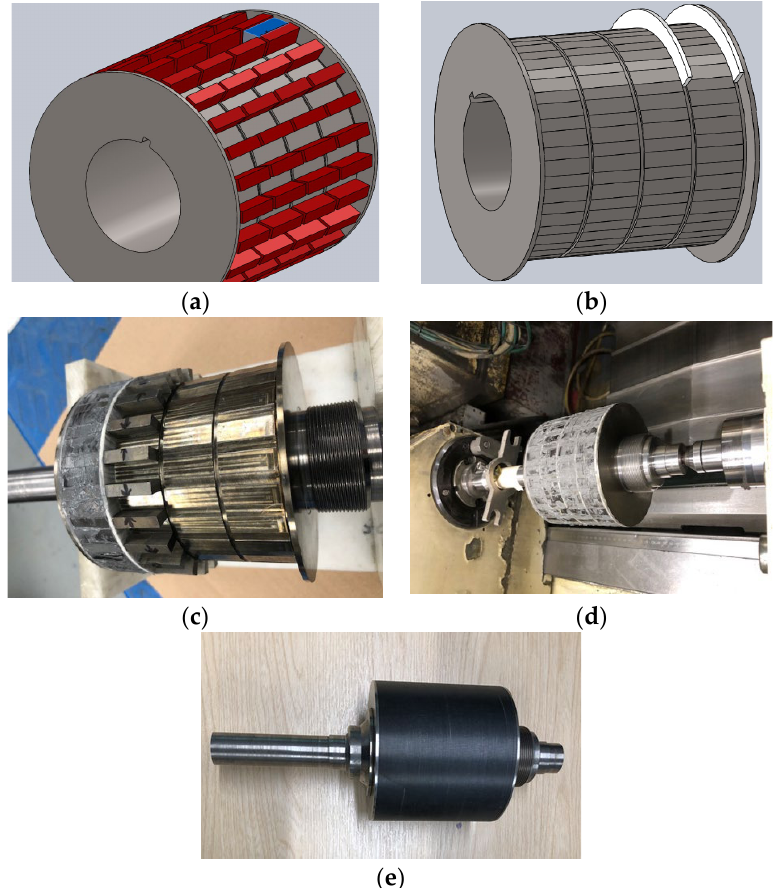
Figure 8. TFM rotor construction: ( a ) Titanium rotor with SMC (shown red) poles, ( b ) ceramic spacers between rotor sections, ( c ) assembly of flux concentrating poles on the rotor body, ( d ) 0.5 mm grinding of rotor surface ( e ) 0.7 mm carbon fiber retaining sleeve on the rotor (15,000 rpm).